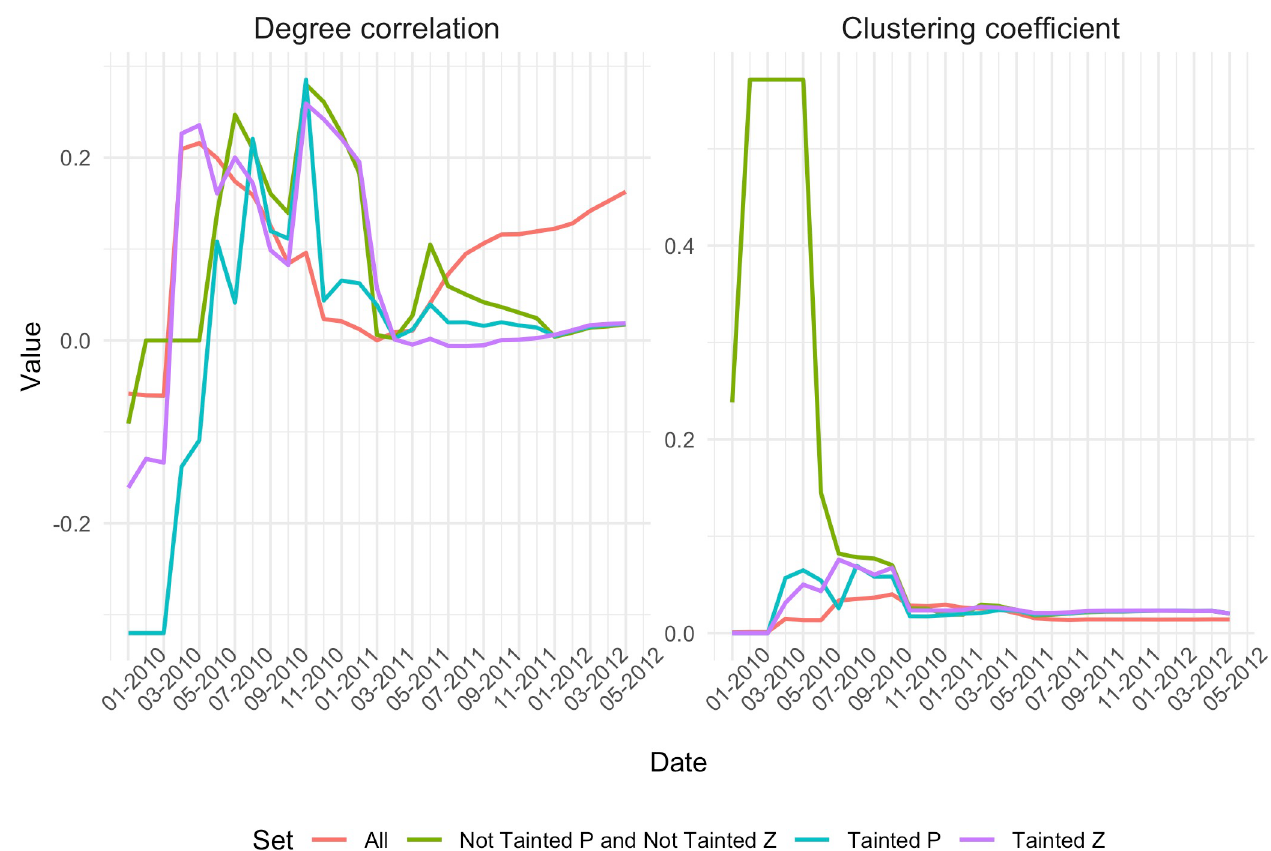
Fig 4. Evolution of degree correlation and clustering coefficient for the all transaction network and three